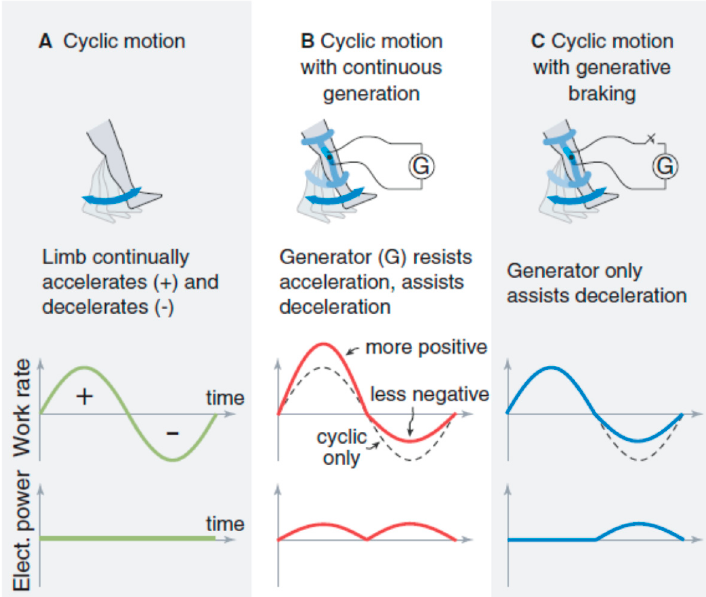
Figure 9. Generative braking [47]. Harvesting energy from negative work: ( A ) cyclic motion of limb without an energy harvester, ( B ) with continuous generation, and (C) with generative braking. Reproduced with permission from the American Association for the Advancement of Science.